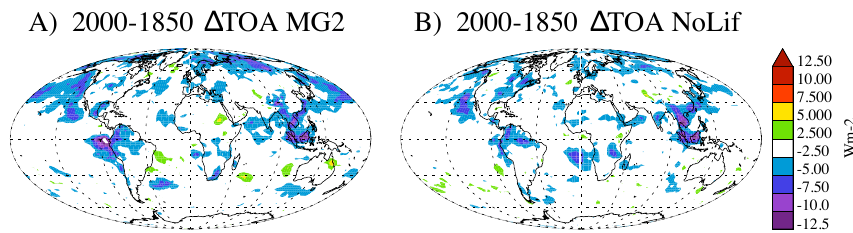
Figure 8. ACI as the total change in the top-of-atmosphere clean-sky cloud radiative effect (CRE) between simulations with 2000 and 1850 aerosol emissions for (a) base (MG2) and (b) no lifetime effect (NoLif)